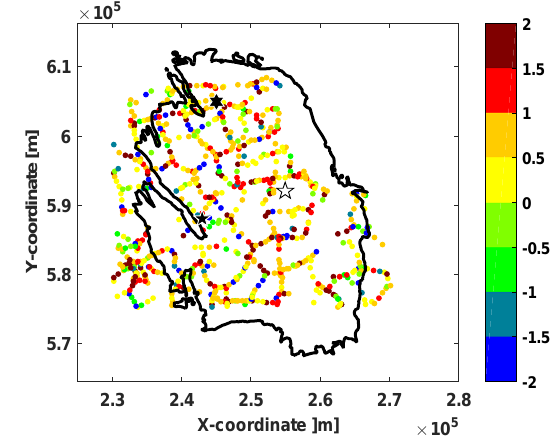
Figure 3. Improvement of the fit of double differences measured for two out of the 92 campaigns towards 1993 (starting times are variable for the different points). The color code indicates the ratio between prior and posterior offset: ( G m lute values of this number smaller than 1 (yellow or green) indicate improvement.